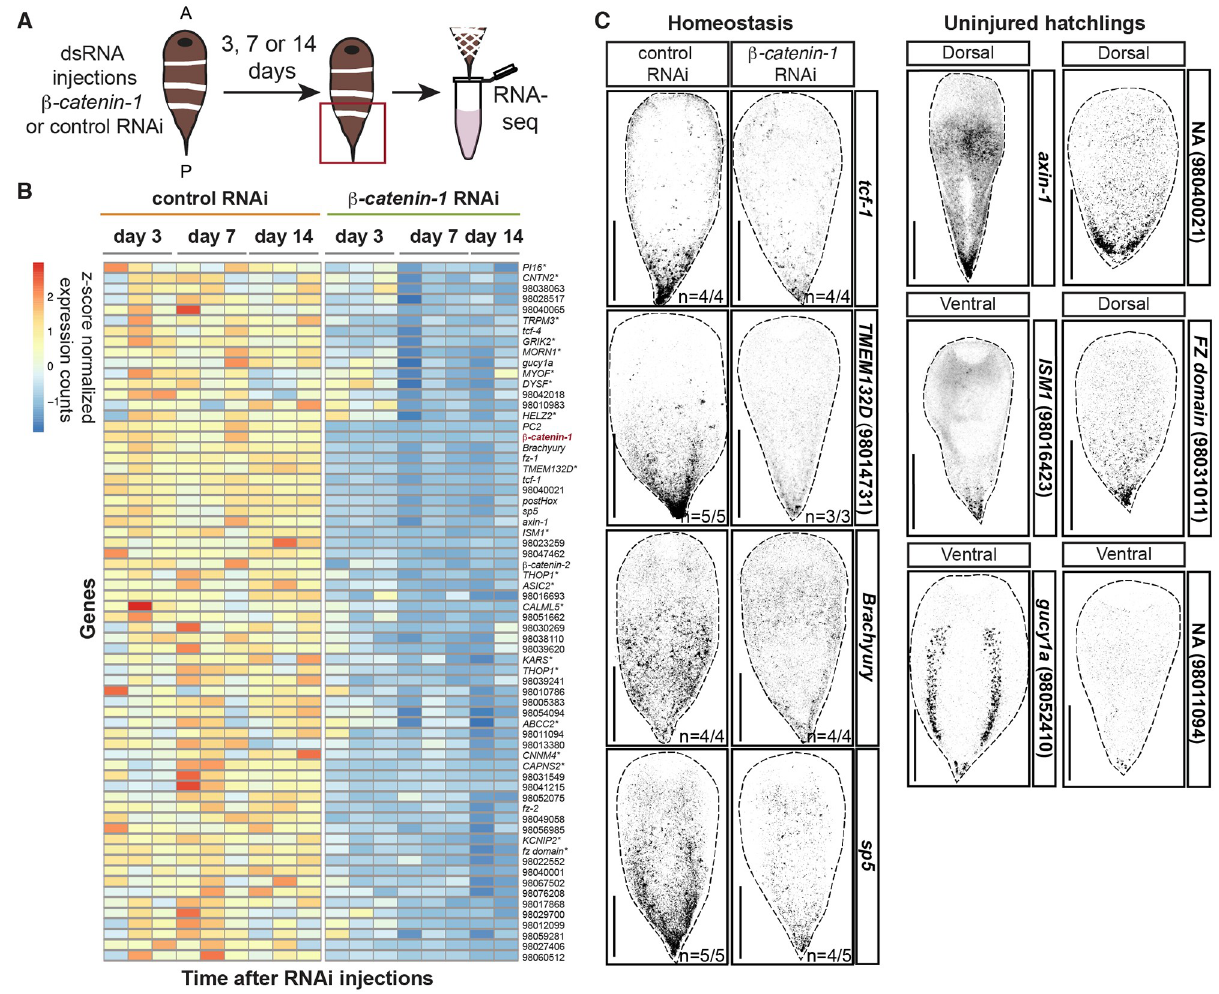
Fig 3. A posterior program of gene expression is down-regulated after β -catenin-1 inhibition in acoels. (A) Experimental scheme for RNA sequencing. Hofstenia miamia were injected once a day for three consecutive days with control or β -catenin-1 dsRNA. Tails were collected in trizol at 3, 7, and 14 days after the first injection for RNA sequencing. Red box indicates tissue collected. (B) A cluster of 66 genes is down-regulated early after β - catenin-1 RNAi. Heatmap displaying gene expression counts as z-scores for indicated timepoints post first RNAi injection. � indicates annotation by best BLAST hit. Gene list provided in S5 Table. (C) Left: Validation of β -catenin-1 RNAi-dependent down-regulation of gene expression. FISH for indicated transcripts at day 9 post-RNAi initiation in homeostasis. Images are presented in grayscale with color inverted. Right: Genes down-regulated after β -catenin-1 RNAi are expressed in the posterior. FISH for indicated transcripts in two week old hatchlings. Transcript ID provided in parentheses. Images are presented in grayscale with color inverted. Scale bars, 200 μ m.